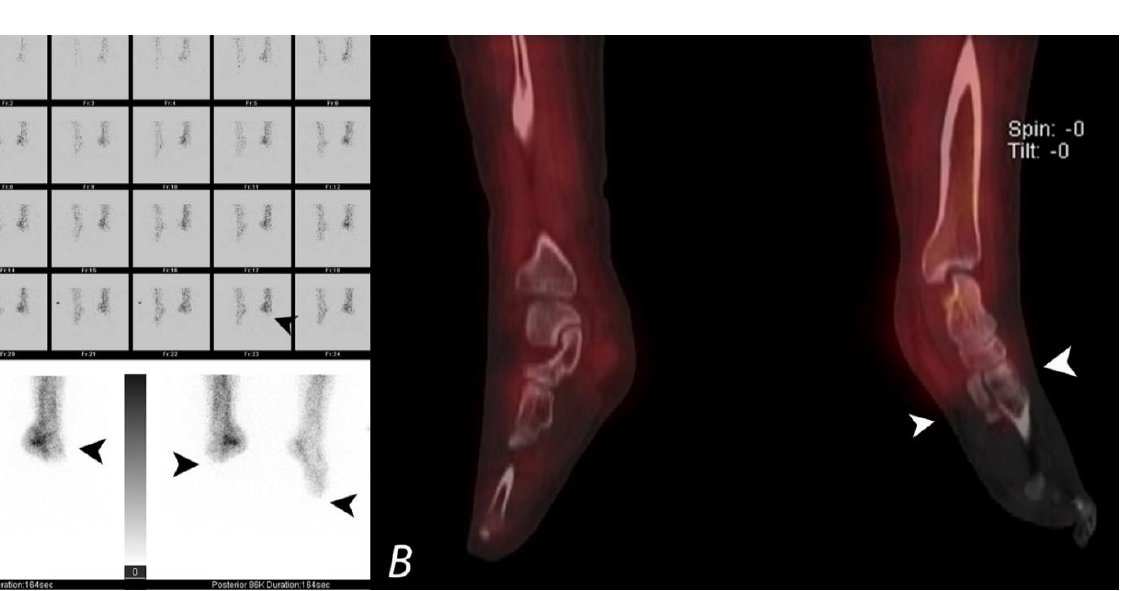
Figure 17. Patient presenting with severe cold injury (frostbite) to bilateral feet underwent three phase bone to evaluate for the extent of devascularization as a part of presurgical evaluation. Blood flow images and blood pool images ( A ) demonstrate absent perfusion and pool activity involving the fore foot and mid foot on the left side and involving the forefoot on the right side. Coronal SPECT/CT ( B ) confirms the findings with accurate delineation and demarcation of viable and non-viable tissue. Patient underwent bilateral below knee amputation.